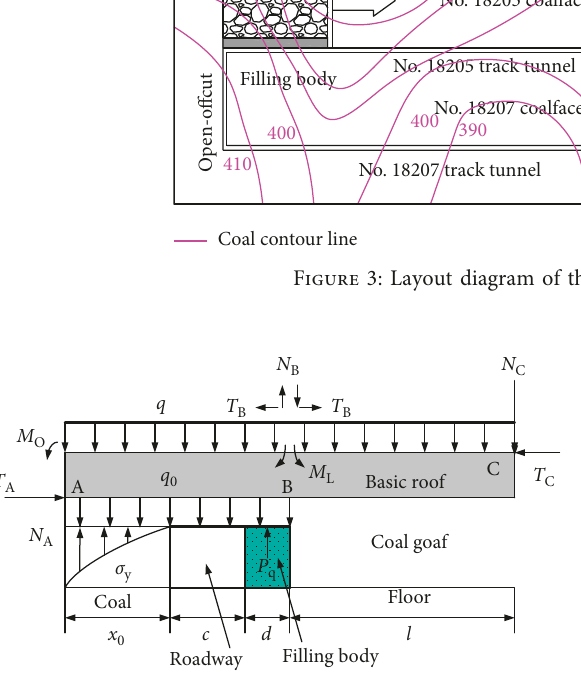
Figure 4: Computing model of roof-cutting resistance of gob-side entry